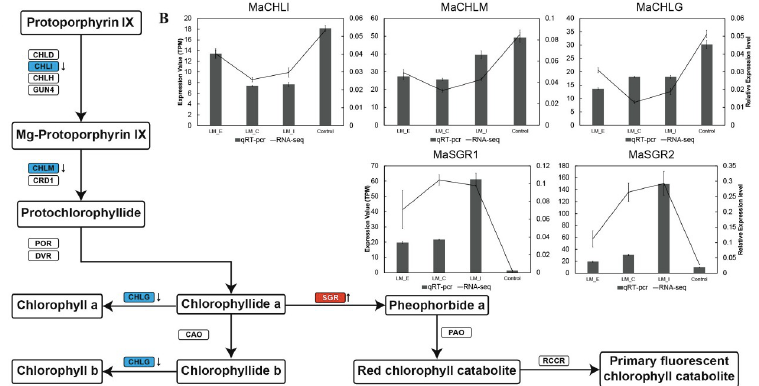
Fig 7. Metabolic network of chlorophyll biosynthesis and degradation in banana leaves. (A) DEGs identified by RNA-seq are shown in colored blocks. Blue blocks represent downregulated genes, and red blocks represent upregulated genes. (B) qRT-PCR analysis and RNA-seq data of MaCHLI , MaCHLM , MaCHLG , MaSGR1 and MaSGR2